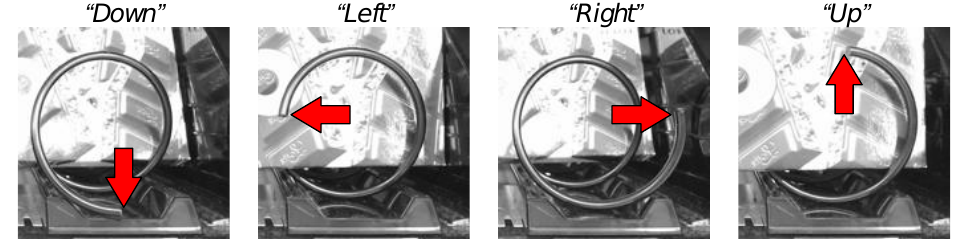
Figure 2. An example of the processed image, and how the 4 classes are defined by the direction the red arrow points